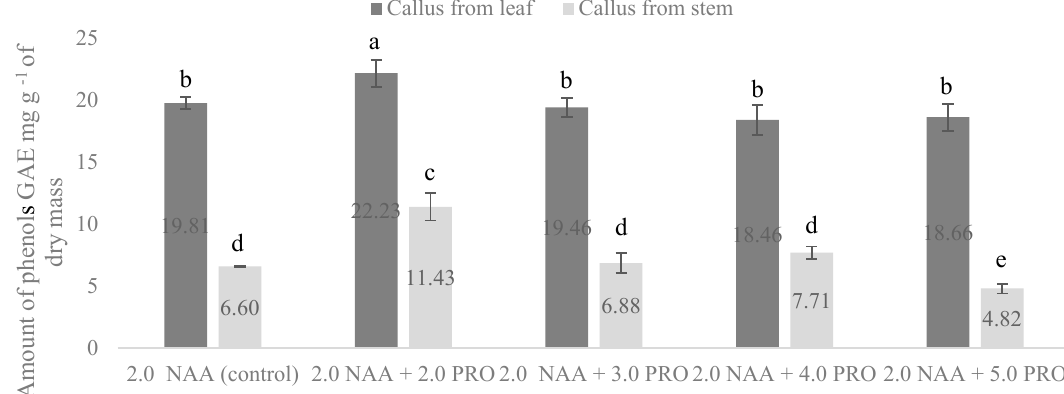
Figure 2. Effect of NAA and PRO concentration on accumulation of total phenolic compounds in callus formed from stem and leaf explants. Means not sharing a common letter were significantly different ( p < 0.05). NAA, α –naphthalene acetic acid; PRO, proline.